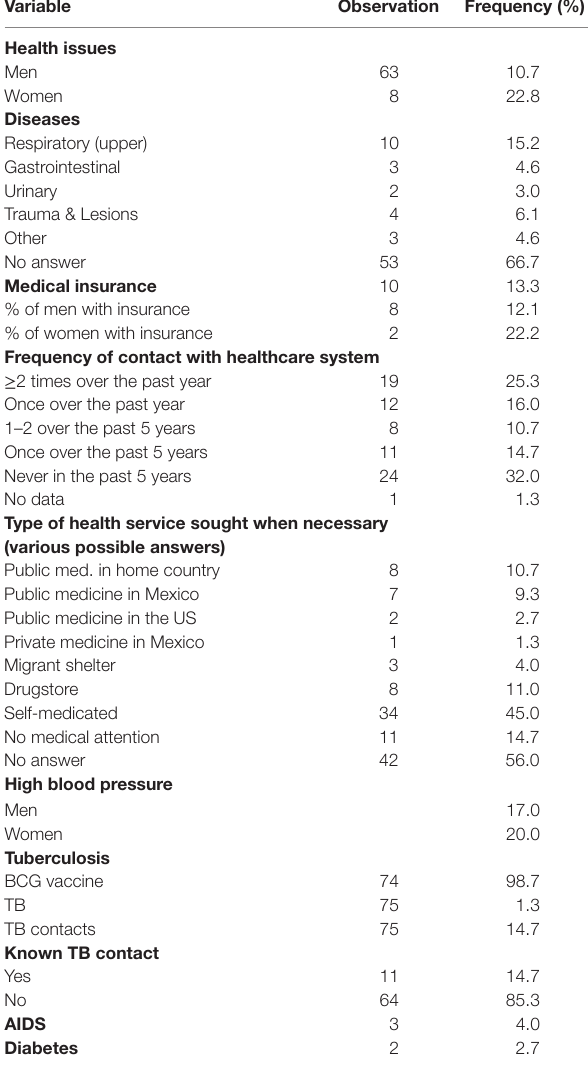
TaBle 3 | health status. TaBle 2 | nutritional assessments and personal habits.